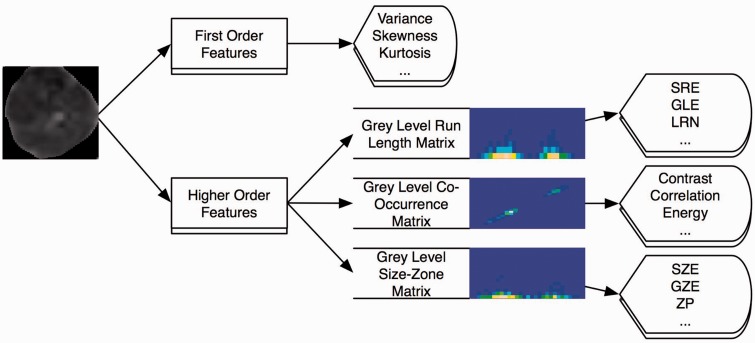
Schematic of feature extraction from an exemplary ROI. The first order features are directly derived from the histogram of the ROI content, while the higher-order features are computed from the respective gray-level matrices.